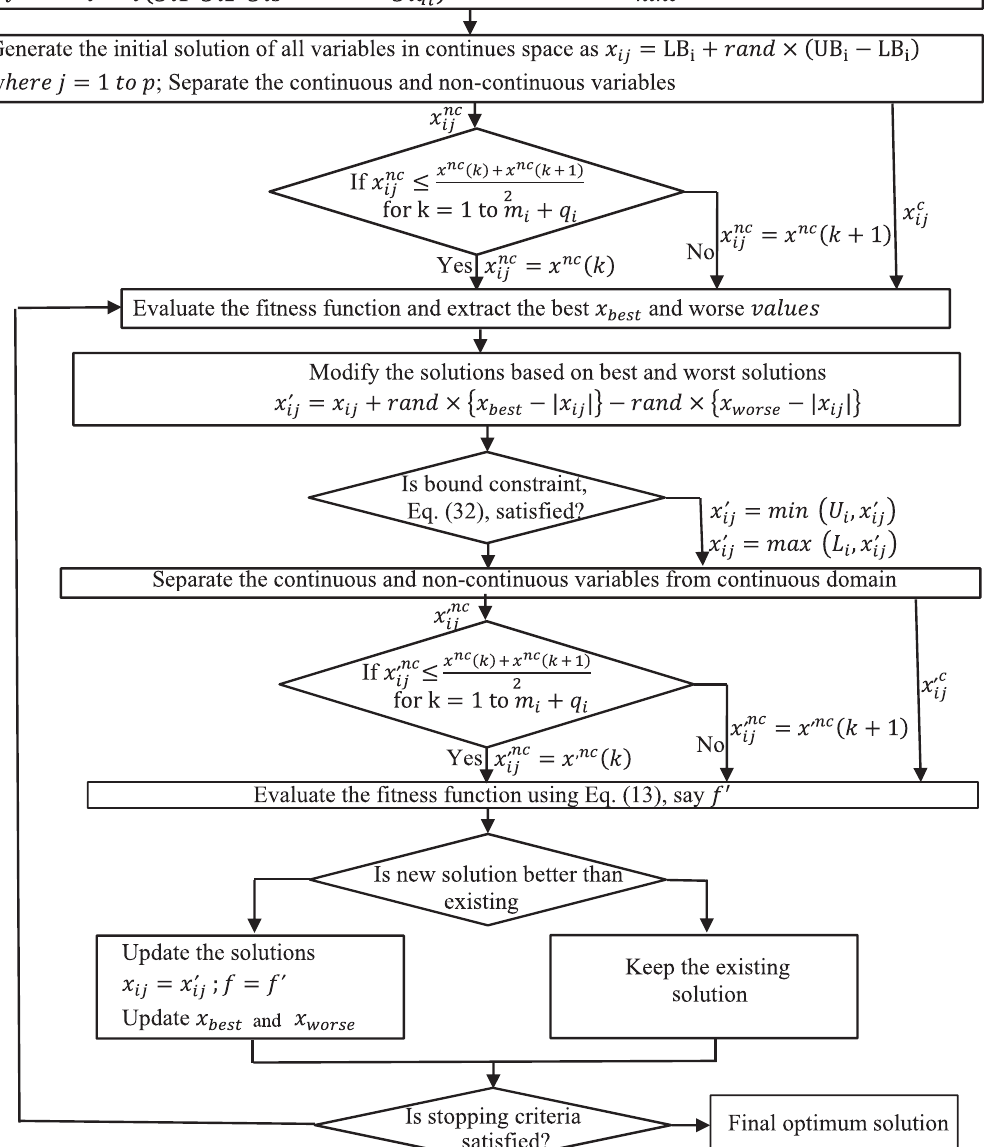
Figure 1: A Modified Jaya Algorithm for Mixed-Variable Optimization